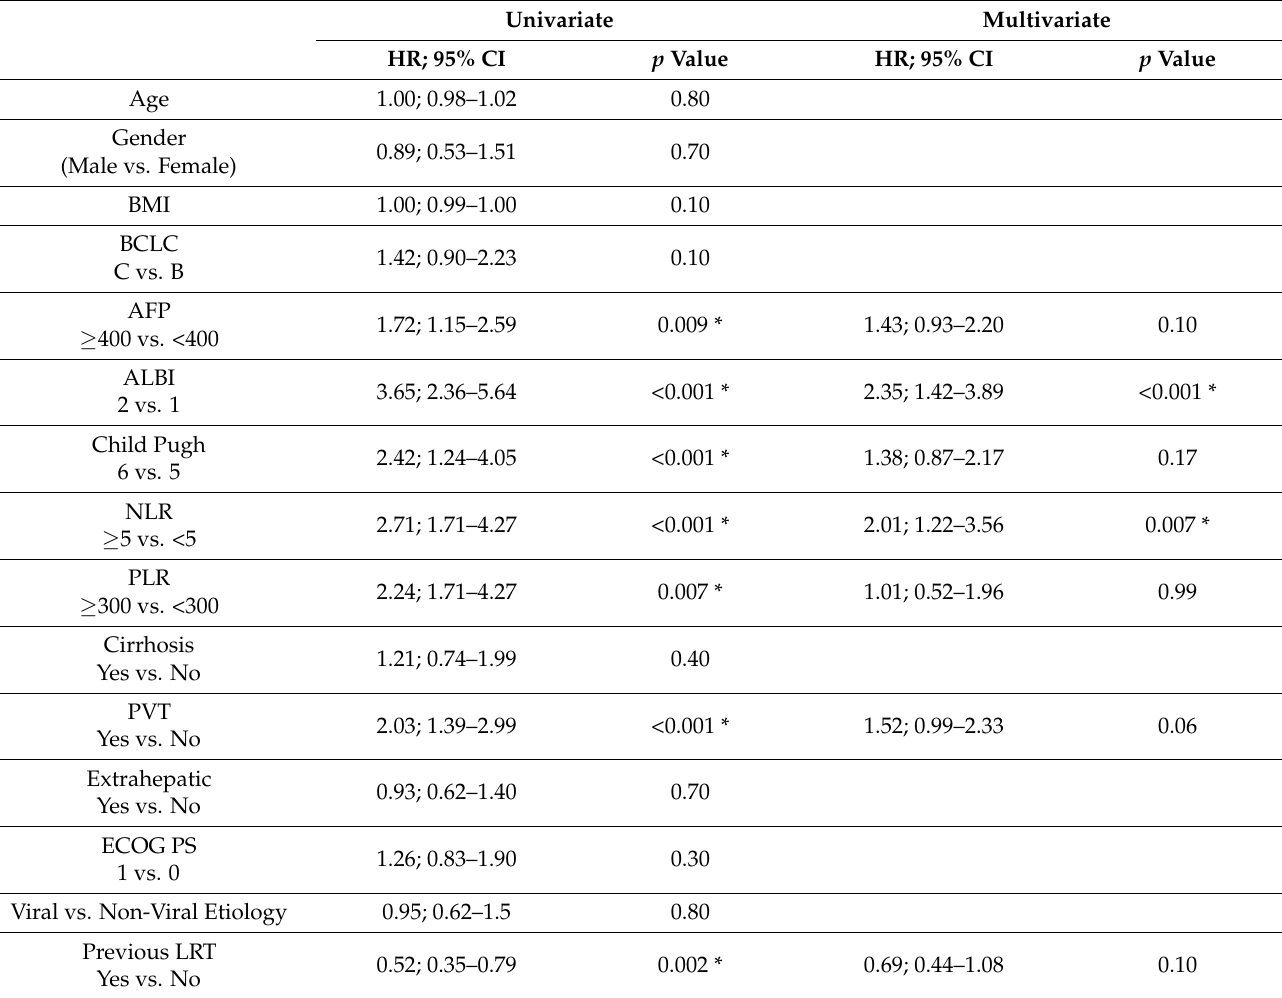
Table 2. Univariate and Multivariate Cox Regression Analyses for Overall Survival.